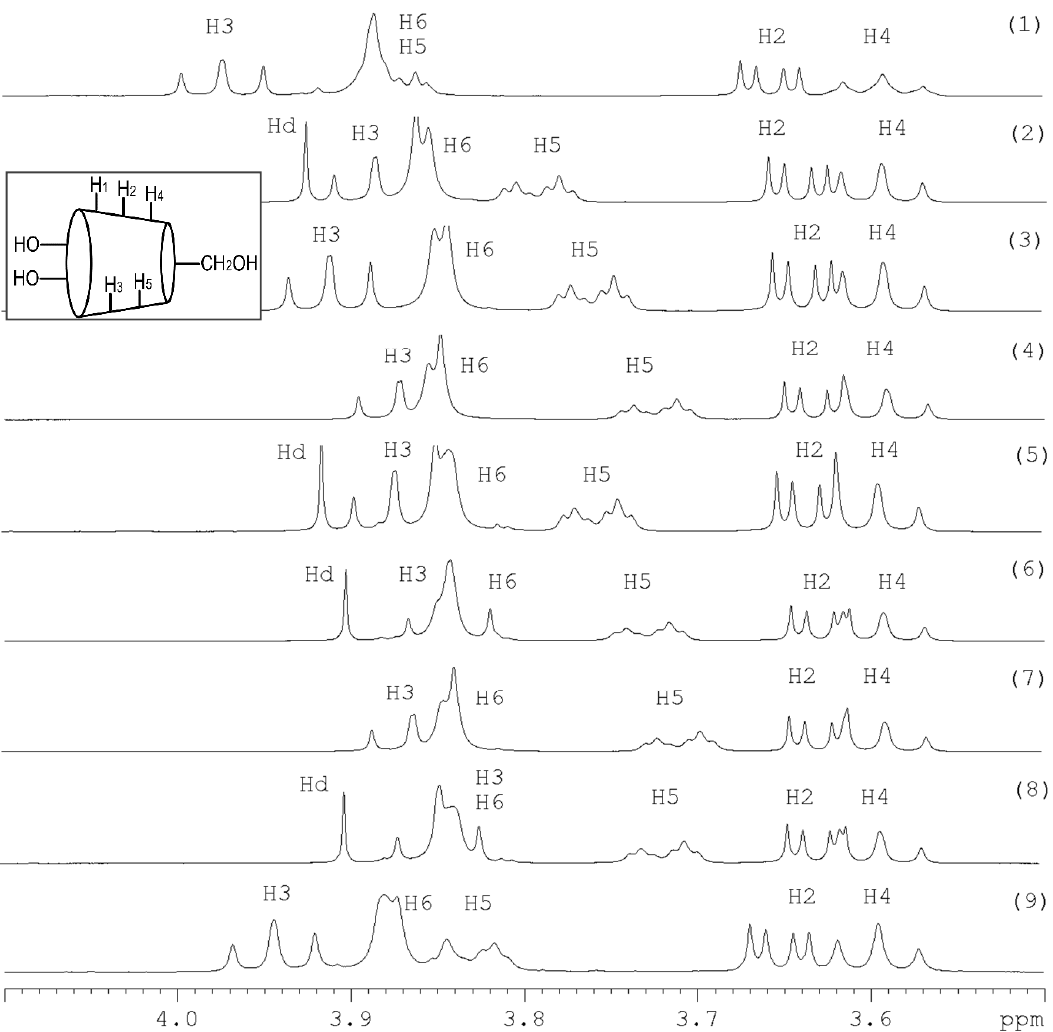
Figure 1. 1 H ‐ NMR ‐ Spectra (400 MHz): (1) β ‐ cyclodextrin, (2) complex of β ‐ cyclodextrin and trans ‐ Figure 1. 1 H-NMR-Spectra (400 MHz): (1) β -cyclodextrin, (2) complex of β -cyclodextrin and trans-ferulic ferulic acid, (3) complex of β ‐ cyclodextrin and caffeic acid, (4) complex of β ‐ cyclodextrin and p ‐ acid, (3) complex of β -cyclodextrin and ca ff eic acid, (4) complex of β -cyclodextrin and p -coumaric coumaric acid, (5) complex of β ‐ cyclodextrin, caffeic acid, and trans ‐ ferulic acid, (6) complex of β ‐ acid, (5) complex of β -cyclodextrin, ca ff eic acid, and trans-ferulic acid, (6) complex of β -cyclodextrin, cyclodextrin, p ‐ coumaric acid, and trans ‐ ferulic acid, (7) complex of β ‐ cyclodextrin, caffeic acid, and p -coumaric acid, and trans-ferulic acid, (7) complex of β -cyclodextrin, ca ff eic acid, and p -coumaric acid, p ‐ coumaric acid, (8) complex of β ‐ cyclodextrin, caffeic acid, trans ‐ ferulic acid, p ‐ coumaric acid, (9) (8) complex of β -cyclodextrin, ca ff eic acid, trans-ferulic acid, p -coumaric acid, (9) wheat bran extract wheat bran extract with β ‐ cyclodextrin each 5 mM in deuterium oxide in the range of 4.10 ppm to 3.50 with β -cyclodextrin each 5 mM in deuterium oxide in the range of 4.10 ppm to 3.50 ppm. Hd is the shift ppm. Hd is the shift from the hydrogen in the deuterium oxide. from the hydrogen in the deuterium